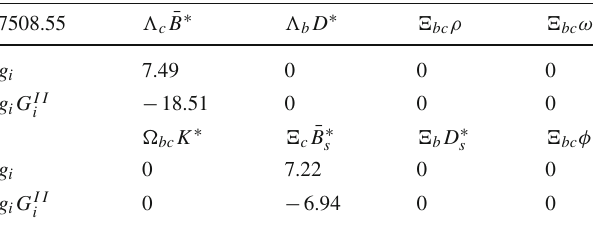
Table 27 Coupling constants to various channels and g i G II in MeV i with q